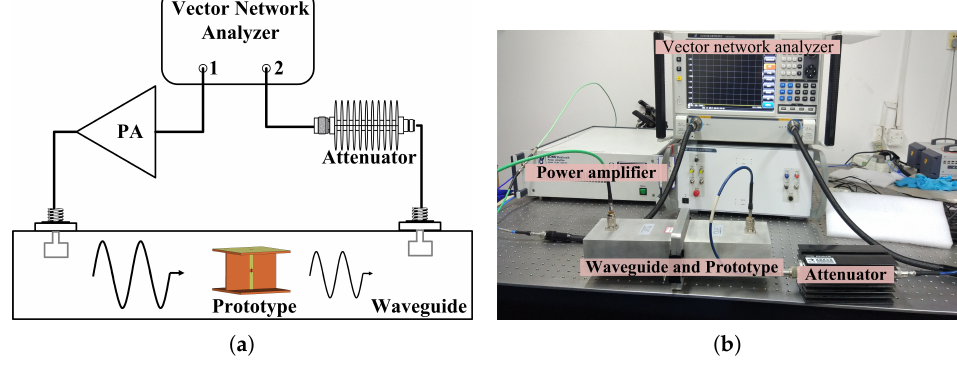
Figure 8. ( a ) Measurement diagram and ( b ) the picture of